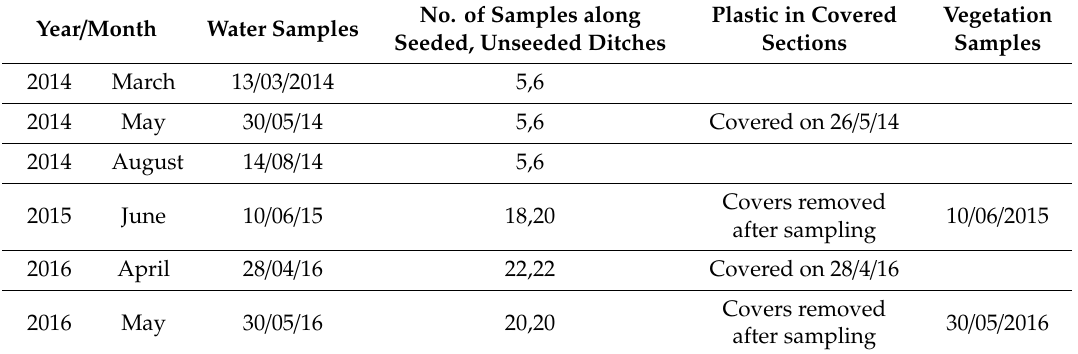
Table 1. Timeline of plastic-covered treatments and sampling of ditches at Pittarthie Farm, 2014–2016. Year / Month Water Samples